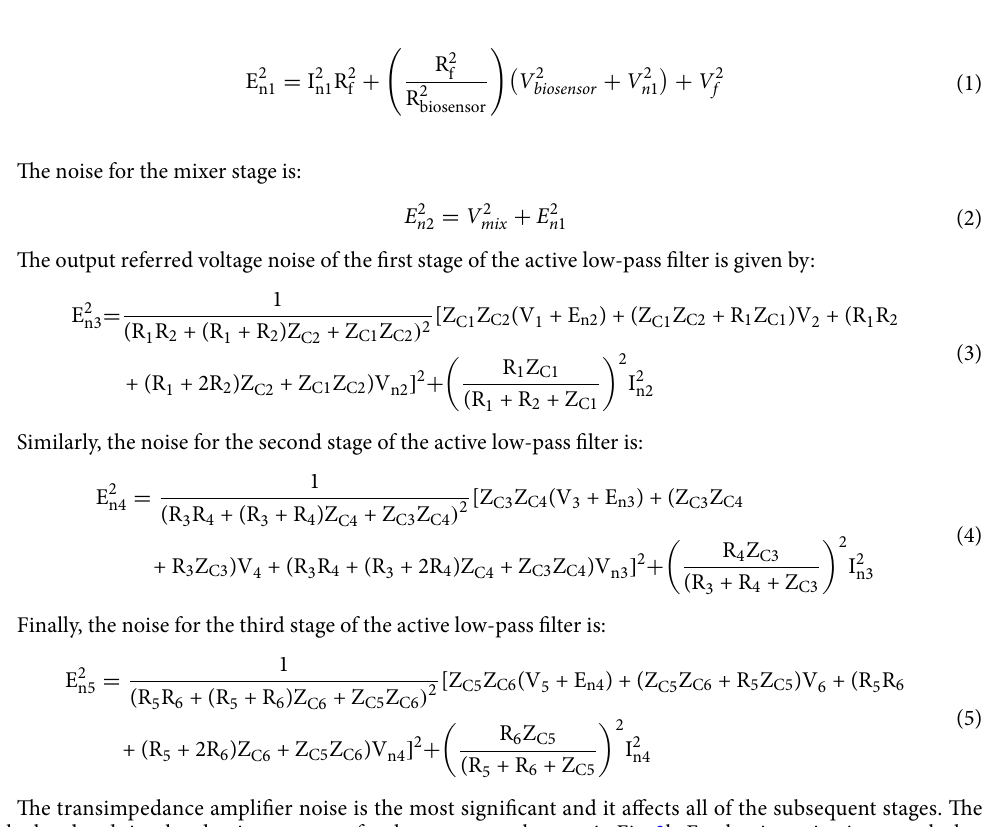
Figure 2. ( a ) Output Voltage (mV) at the Analog-to-Digital Converter (ADC) versus Resistance (kΩ) for the region of interest ( b ) Drift characterization of the circuit using a 2 kΩ